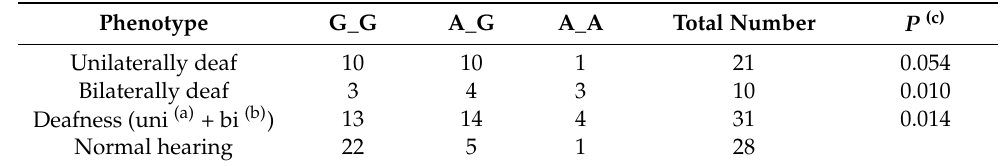
Table 5. Genotype distribution of KLF7 variant in 31 deaf and 28 normal hearing ASCDs